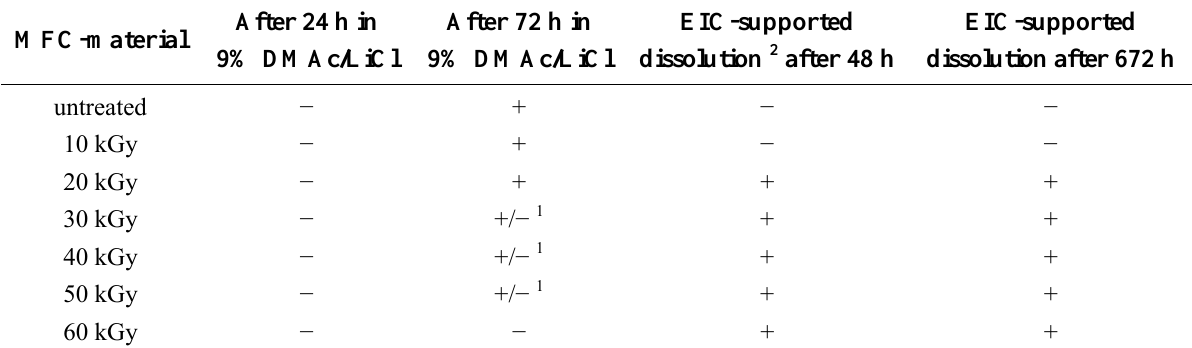
Table 2. Dissolution of NCC (prepared from Whatman cotton filter aid) according to standard solution procedure 2 . NCC material After 48 h After 336 h After 336 h + freezing and thawing Untreated − − + 10 kGy + + + 20 kGy +/ − 1 + + 30 kGy − +/ − 1 + 40 kGy − +/ − 1 + 50 kGy − − + 60 kGy − −